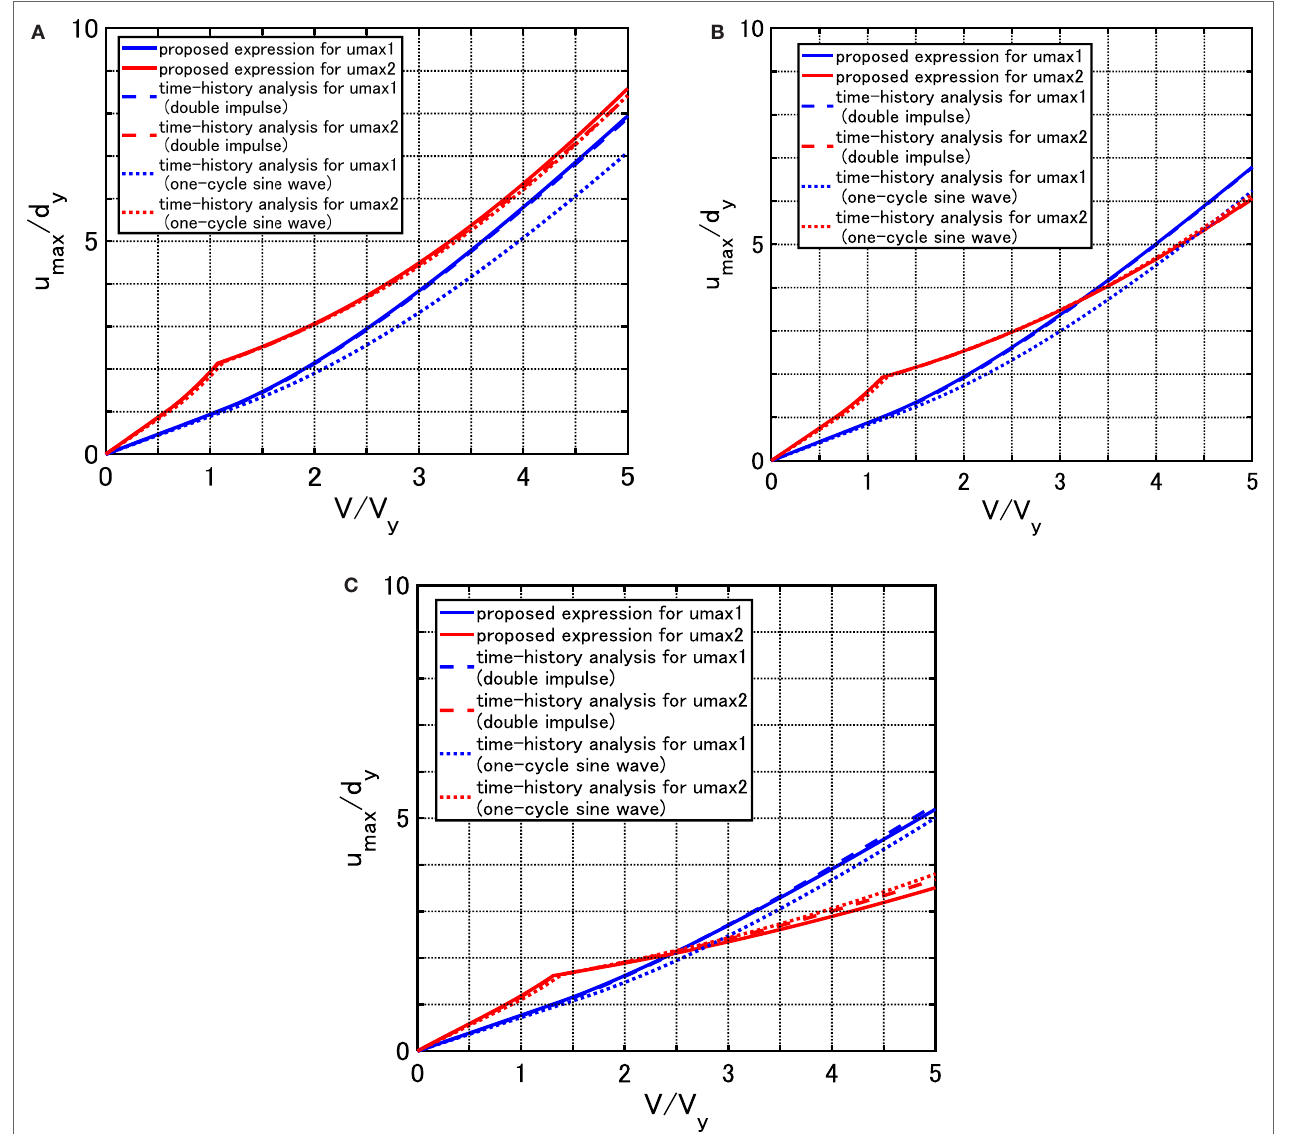
FIGURE 9 | Comparison of maximum deformations for model of α = 0.1 among proposed method, time-history response analysis under double impulse and time-history response analysis under corresponding one-cycle sine wave, (A) h = 0.05, (B) h = 0.1, and (C) h = 0.2.